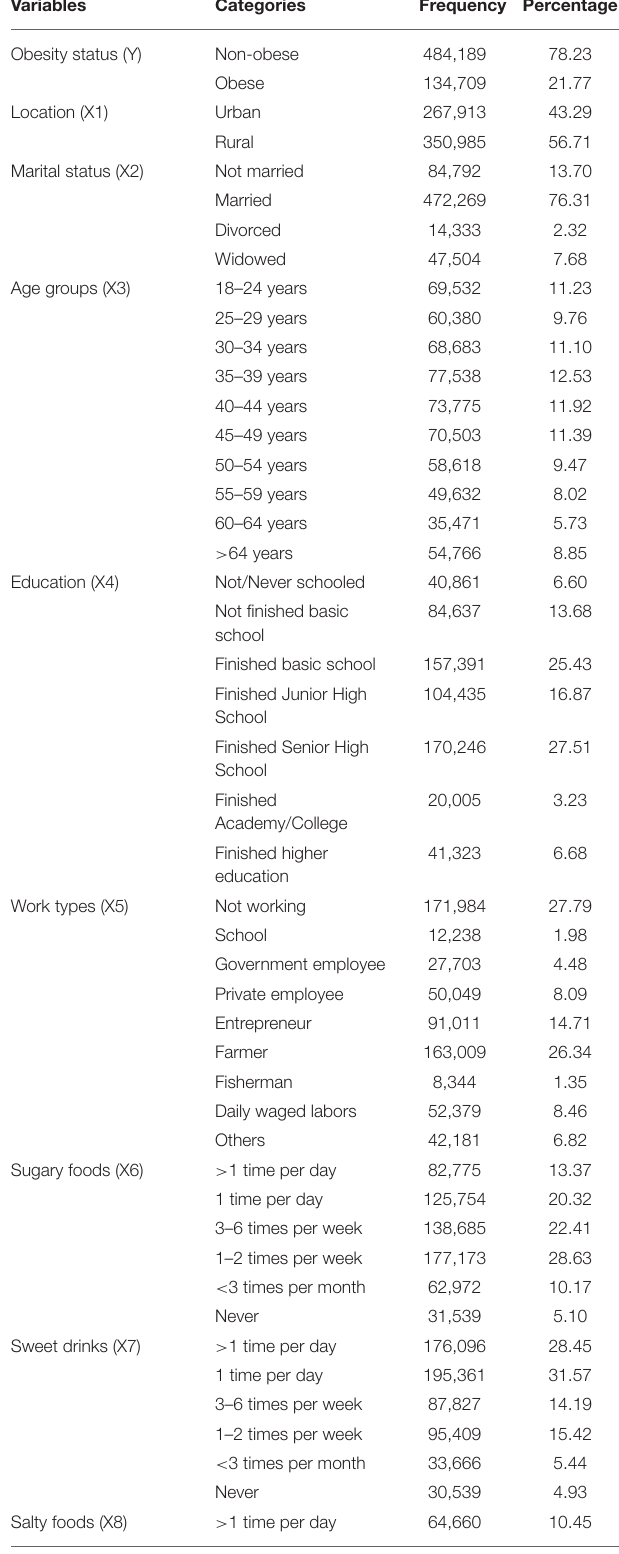
TABLE 1 | General description of obesity data from Indonesian RISKESDAS